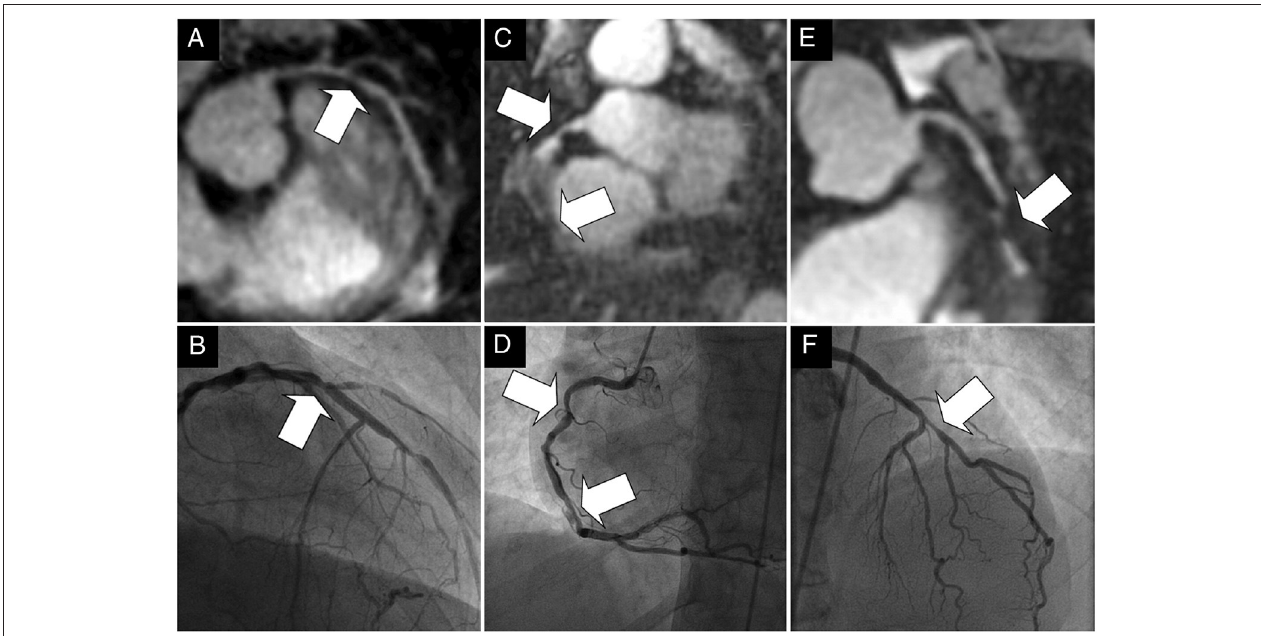
FIGURE 1 | (A–F) Examples of the comparison between multiplanar reformats of the whole-heart 1D self-navigated CMRA data sets (top row) and the corresponding x-ray coronary angiograms (bottom row) in three patients. The lesion in the proximal LAD artery and just distal to the take-off of a diagonal branch can clearly be identified in the first patient in (A). while this is confirmed on the x-ray angiogram in (B) . While the luminal narrowing of the proximal RCA in the second patient on (C). can clearly be identified, the further course of this artery is obscured in the region of a stent. The same in stent restenoses can be identified in (D) . In the third patient in (E). significant disease is identified in the proximal LAD artery at CMRA and is confirmed on, (F). the corresponding x-ray coronary angiogram. Arrows = stenoses; LAD, left anterior descending artery; RCA, right coronary artery. Adapted with permission from Piccini et al.